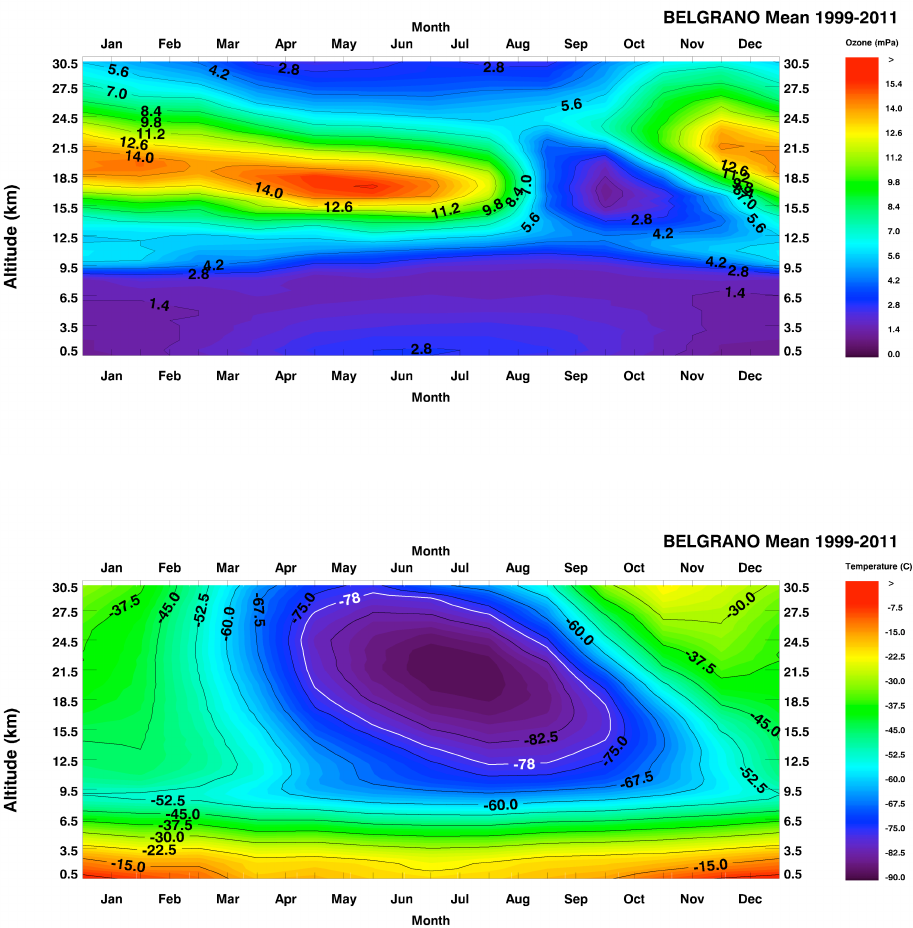
Fig. 2. Time–height cross sections of ozone (upper panel) and temperature (lower panel) over Belgrano obtained from the monthly mean profiles for the period (1999–2011). The isothermal of − 78 ◦ C is plotted in white, defining approximately the boundaries of time and height Figure 2. Time-height cross-sections of ozone (upper panel) and temperature (lower panel) 5 where PSC formation is over Belgrano obtained from the monthly mean profiles for the period (1999-2011). The 6 isothermal of -78ºC is plotted in white, defining approximately the boundaries of time and 7 height where PSC formation is possible. 8